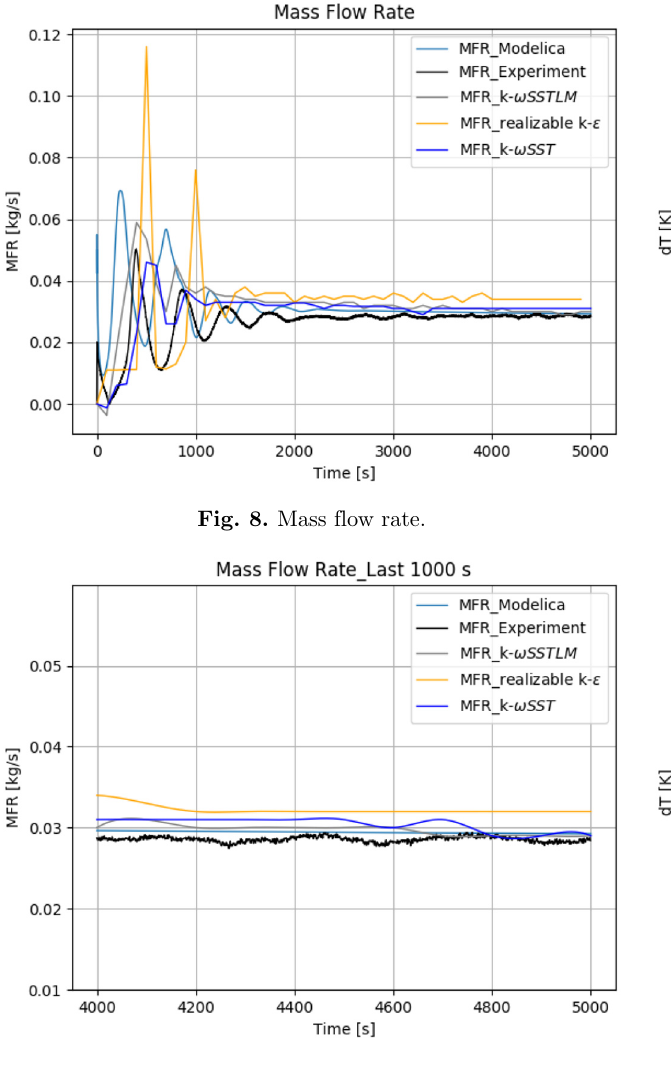
Fig. 9. Mass flow rate for the last 1000 s of the simulation. Table 8. Average stabilized mass flow rate compared to the experiment.